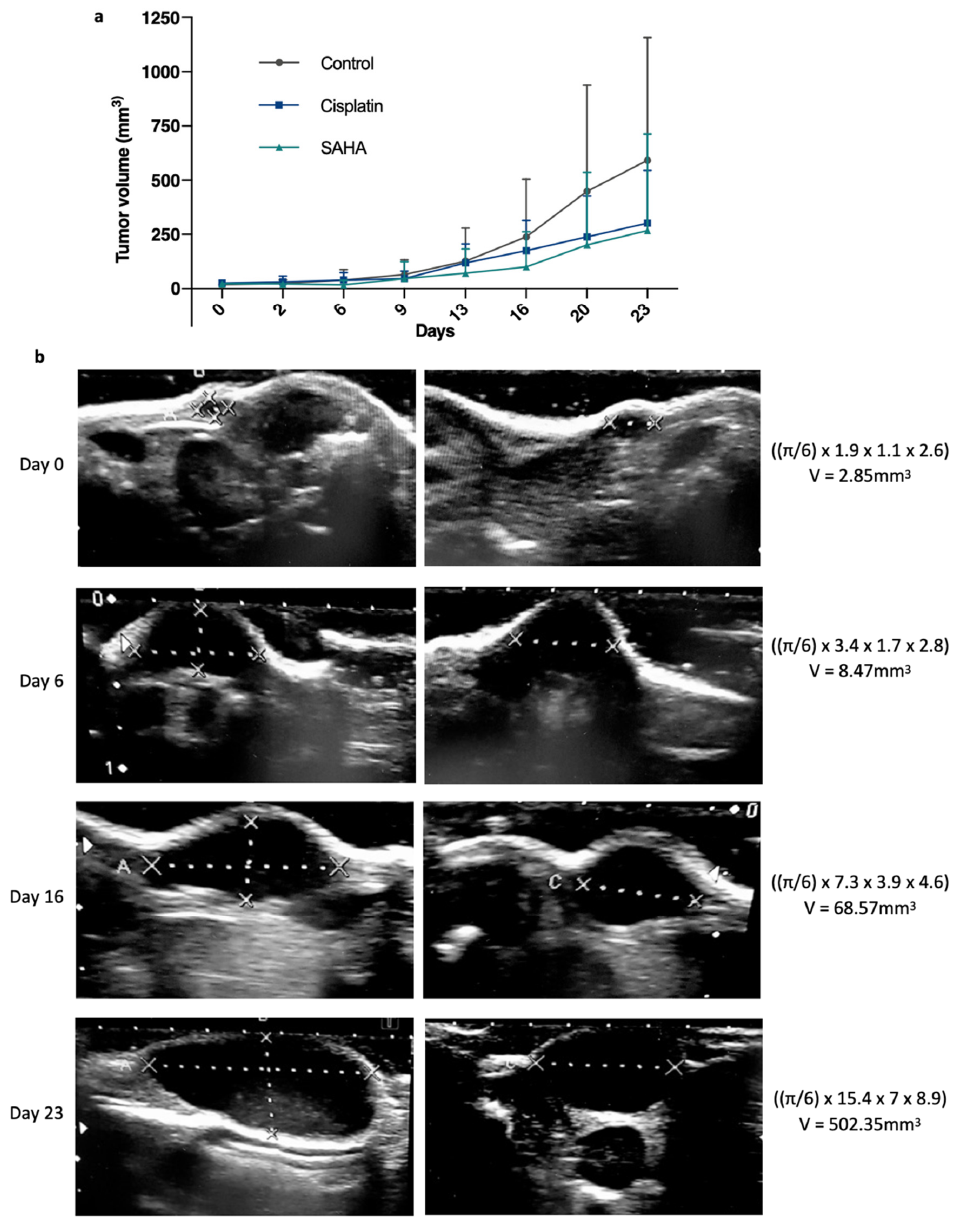
Figure 2. Evolution of the gastric tumor growth between treated and non-treated tumors. ( a ) Average tumor volume growth over time, measured by a manual caliper on living mice from day 0 to day 23, between suberanilohydroxamic acid (SAHA, HDAC inhibitor), standard chemotherapy using cisplatin, which targets DNA, and a control group ( n = 12, 12, 8). p < 0.05 between control and treated groups as established by a t -test. ( b ) Illustration of representative ultrasound images and calculations showing the evolution of a GCX-004 tumor from the control group over time (day 0, day 6, day 16, and day 23).